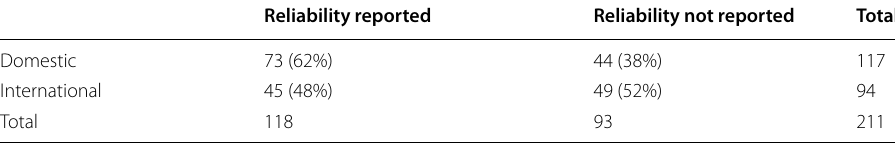
Table 2 frequency of reliability reporting in domestic and international theses Reliability